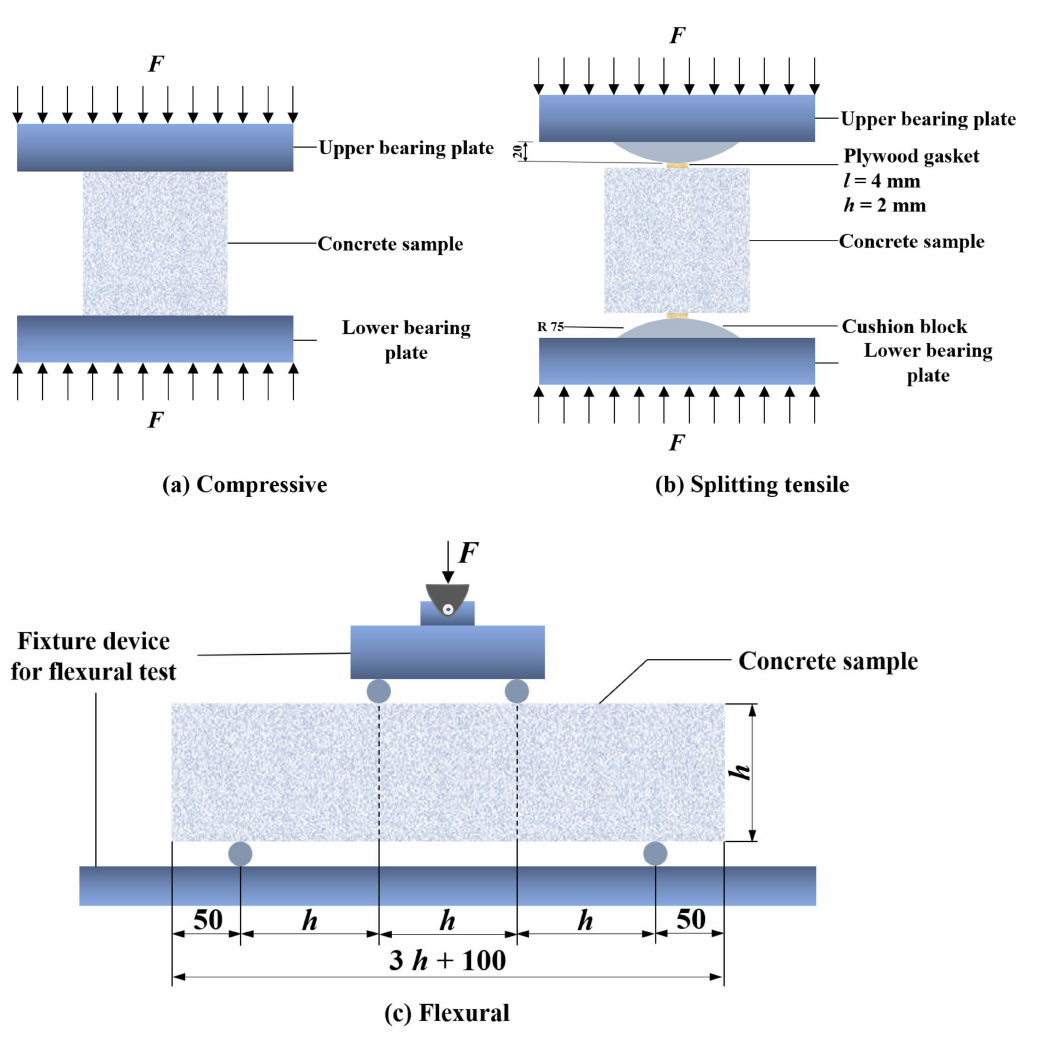
Figure 3. Schematic diagram of the tests on basic mechanical properties. ( a ) Cube compressive test; ( b ) Splitting tensile test; ( c ) Flexural